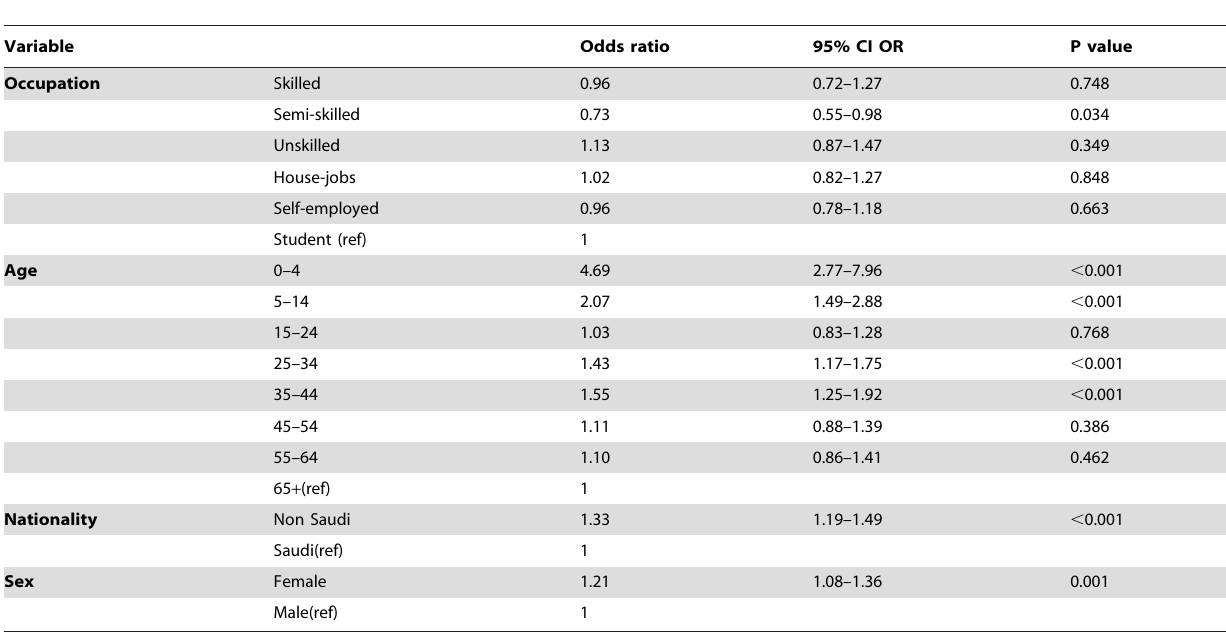
Table 6. Logistic regression predicting extra-pulmonary tuberculosis from occupation, age, nationality, and sex.